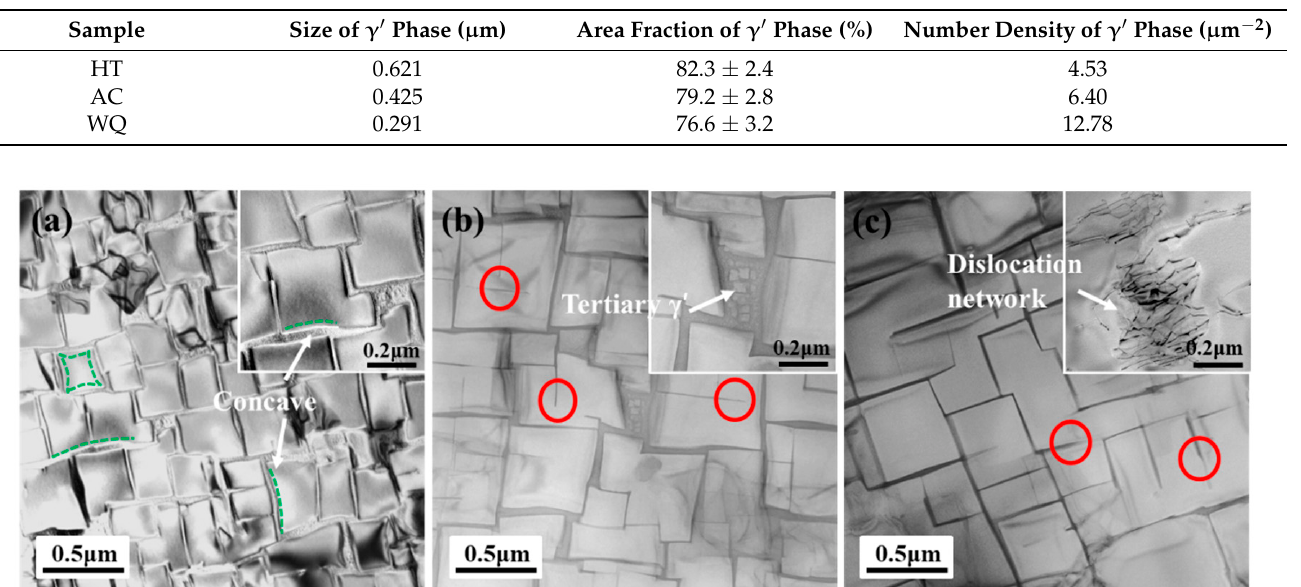
Figure 5. The TEM microstructure of γ′ phases after different heat treatment schedule: ( a ) WQ; ( b ) AC and ( c ) HT.